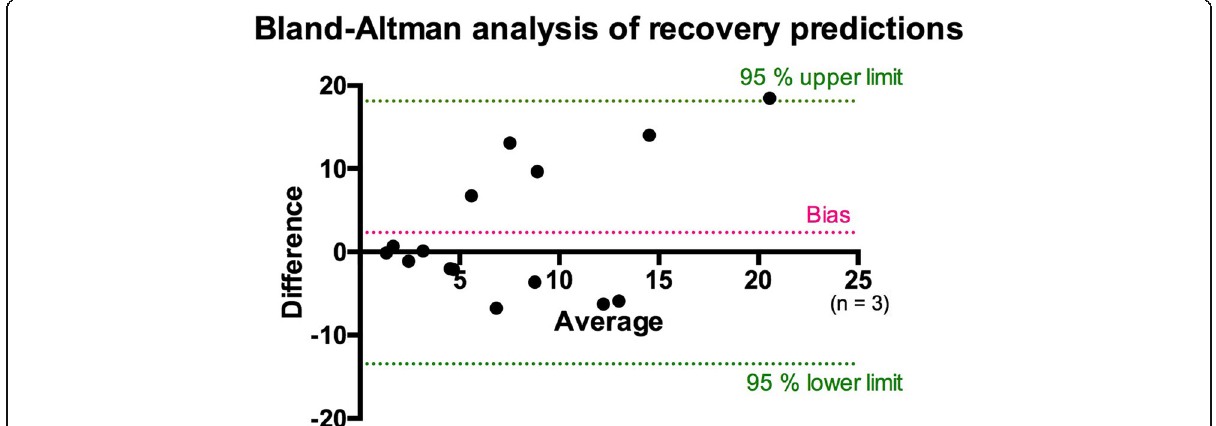
Fig. 4 Bland-Altman analysis of the predicted injury volumes in the validation cohort. Predictions were compared to the injury volumes during all follow-up time points. Red dotted line corresponds to the bias, with corresponding lower and upper limits of agreement at 95% represented with green dotted